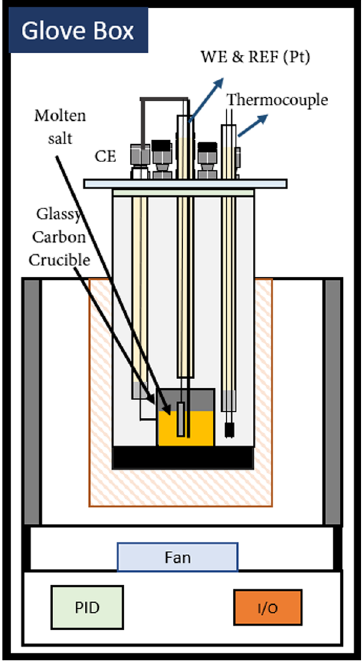
Fig. 7 Schematics of the experimental setup used for molten salt electrochemical